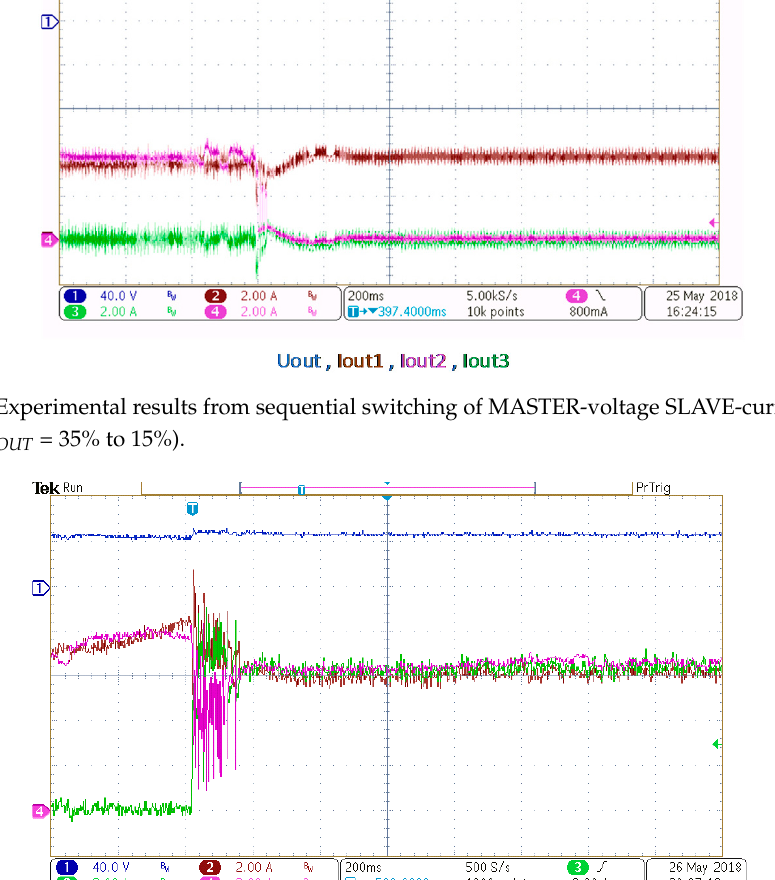
Figure 16. Experimental results from sequential switching of MASTER-voltage SLAVE-current control strategy ( P OUT = 40% to 60%) .